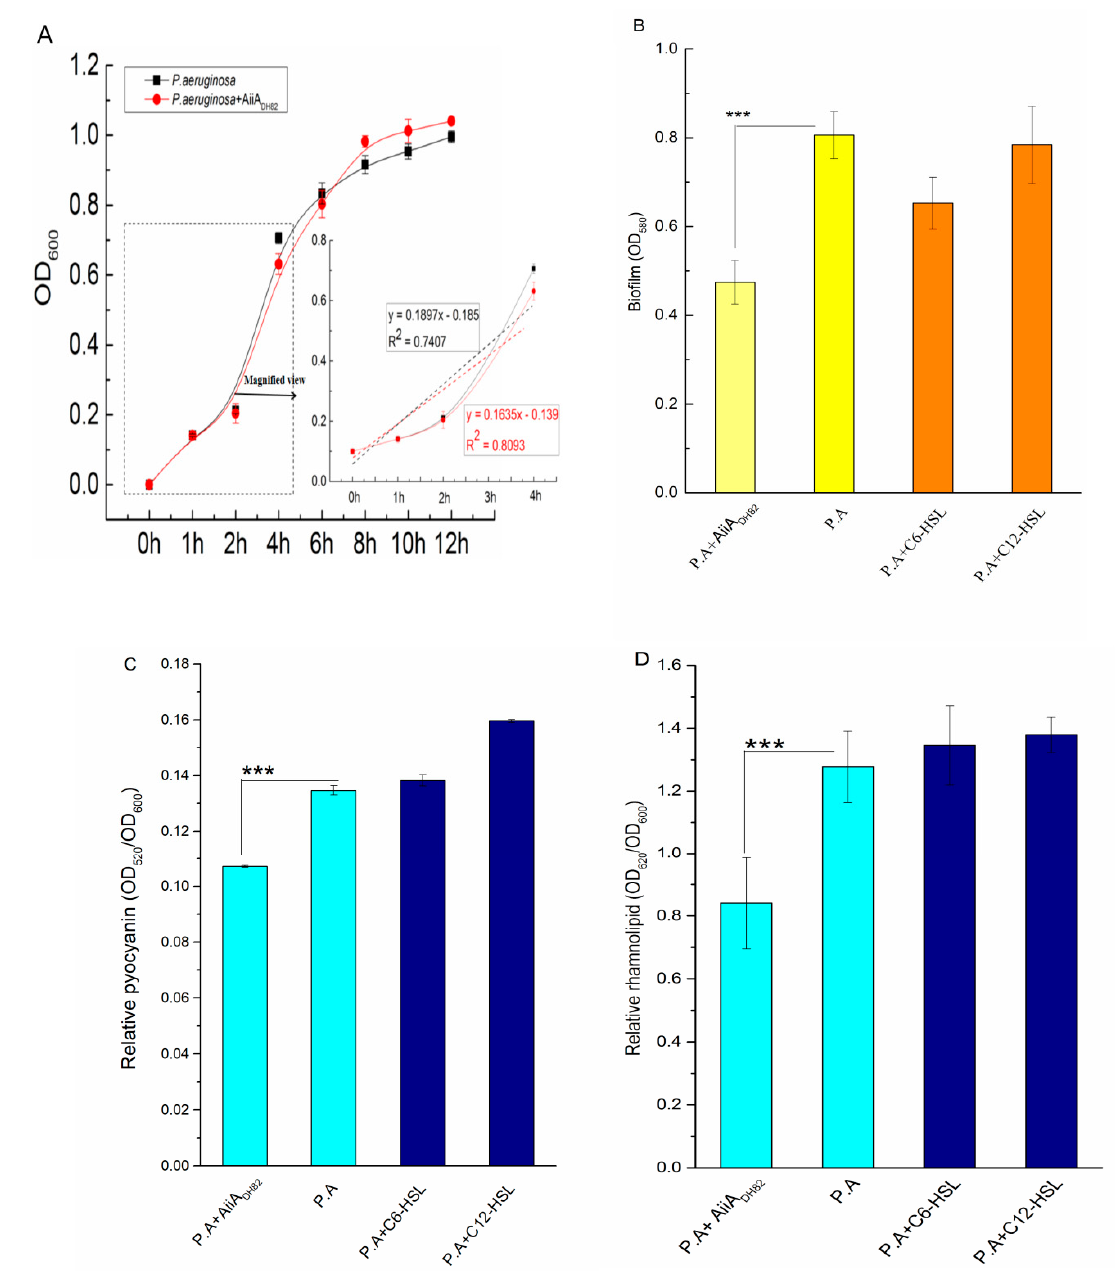
Figure 5. Bacterial interruption of thequorum quenching (QQ) enzyme against P. aeruginosa . Here, 1.5 mg/mL AiiA DH82 was inoculated to the bacterial culture for treatment, the curve of bacterial density for growth, biofilm accumulation, and amount of released pyocyanin and rhamnolipid were determined by absorbance at 600, 580, 520, and 620 nm, respectively, measured using a microplate reader. Figure 5 shows the ( A ) growth curve of P. aeruginosa (bacterial culture with enzyme treatment in red, negative control in black), ( B ) biofilm formed by P. aeruginosa (biofilm with enzyme treatment in light yellow, non-treated biofilm in yellow, and biofilm with the addition of AHL in orange), ( C ) released pyocyanin, and ( D ) released rhamnolipid (bacterial culture with enzyme treatment in light cyan, non-treated bacterial culture in cyan, and bacterial culture with the addition of AHLs in navy). Error bars are present to determine the standard deviation. Statistic analysis results with significant difference are marked using * (significant differences at p < 0.01 marked as ***).